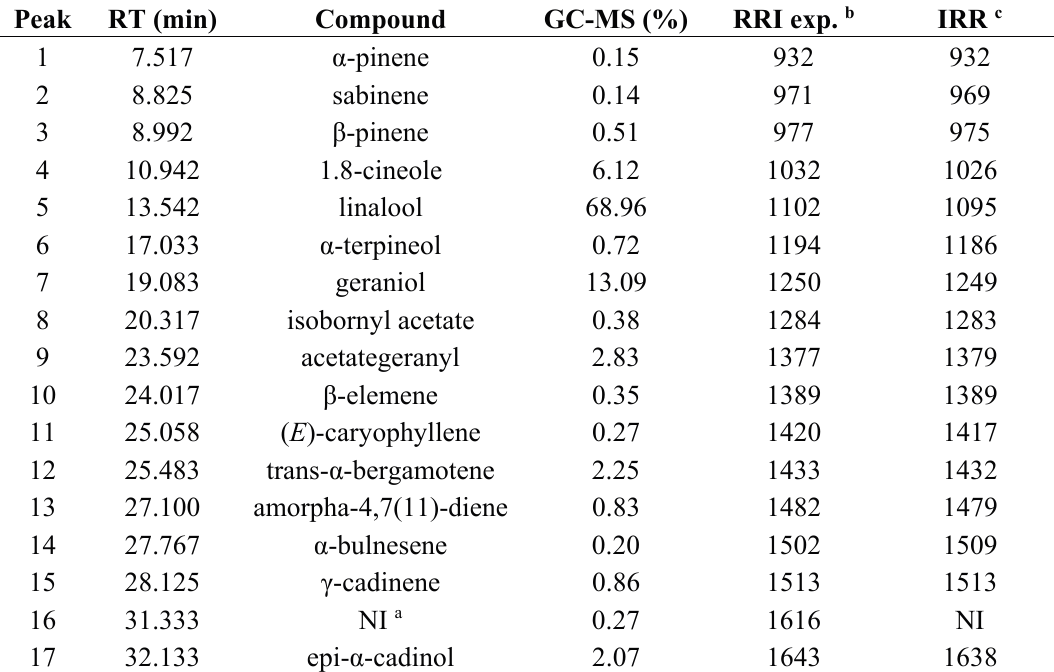
Table 1. Volatile composition of leaf essential oil of Ocimum basilicum